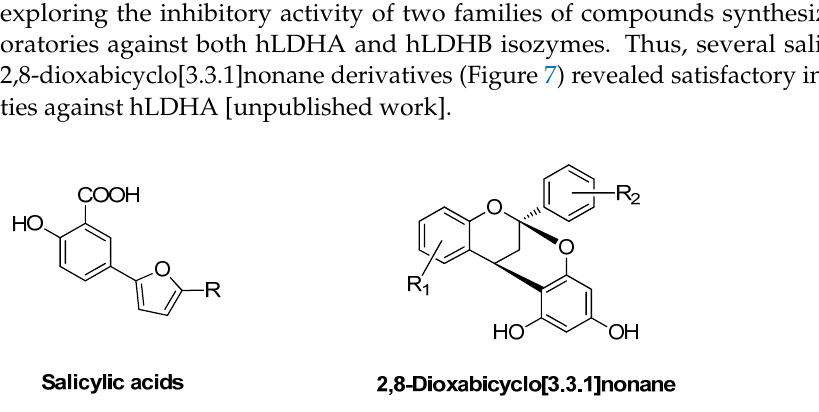
Figure 7. General structures of salicylic acid and 2,8-dioxabicyclo[3.3.1]nonane derivatives.